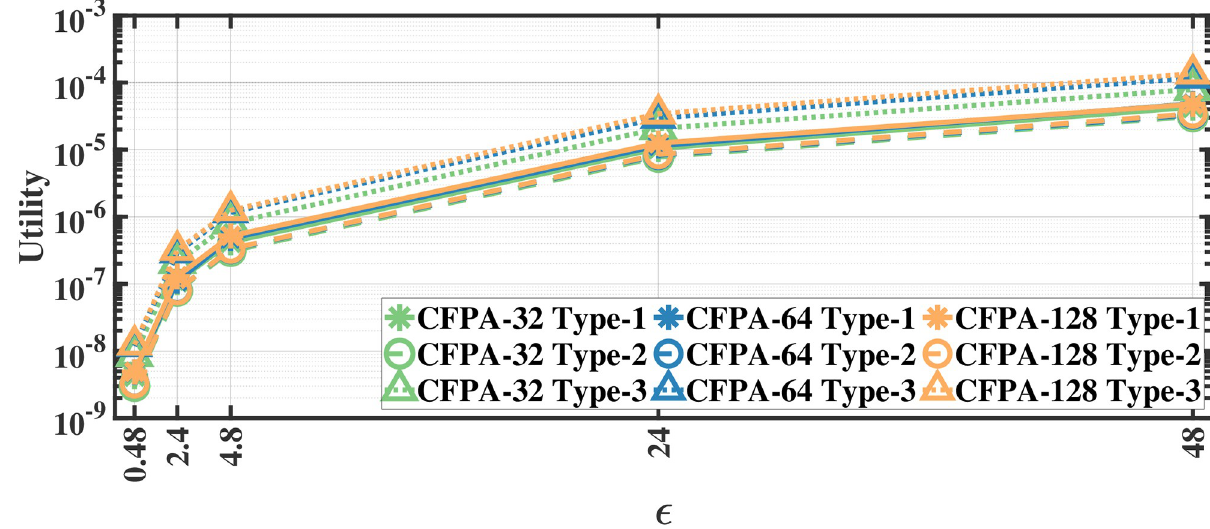
Fig 11. Utility of the CFPA for MPIIPrivacEye.